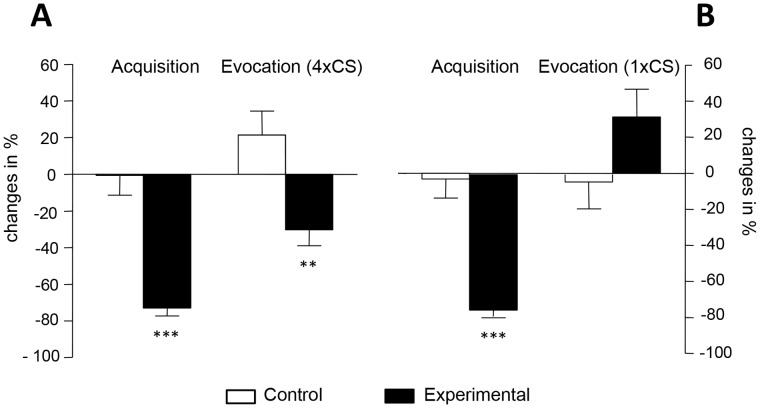
Behavioral conditioning induced cytokine response.Behaviorally conditioned suppression of IL-2 release was observed after four CS re-expositions (control group n = 15, experimental group n = 17) (Fig. 2A). In contrast, a single CS re-exposition did not induce a significant inhibition in IL-2 production (control group n = 9, experimental group n = 10) (Fig. 2B). Data are expressed as percental changes from baseline. Bars represent mean ± SEM; ** p<0.01, *** p<0.001.